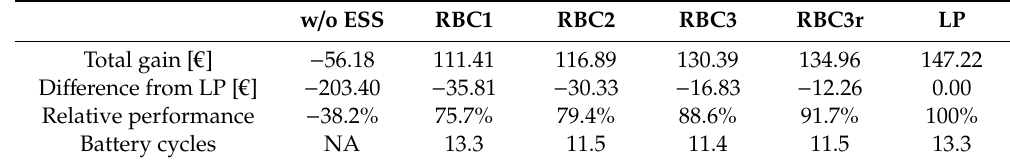
Table 3. Corrected tari ff results: Total gain and battery